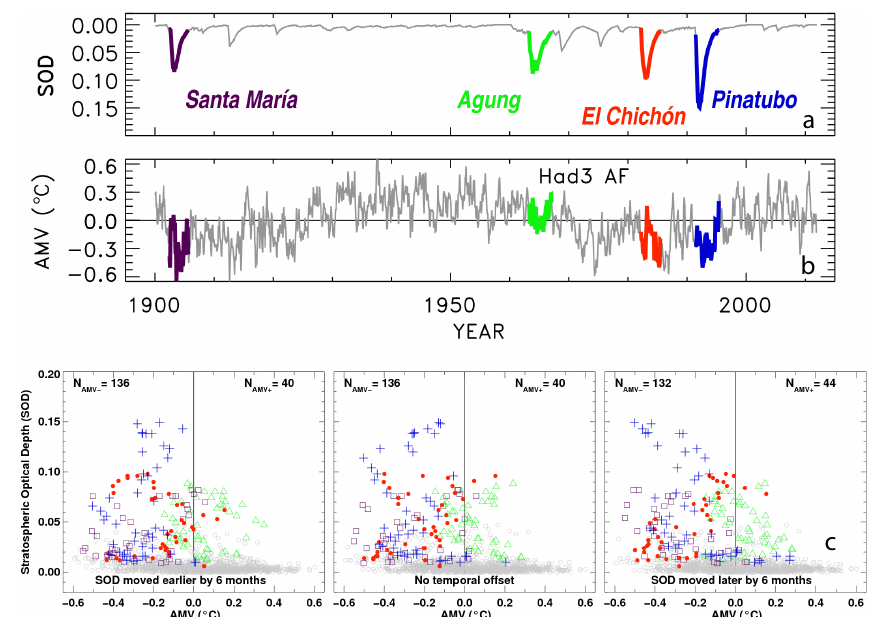
Fig. 10. (a) Monthly mean stratospheric optical depth (SOD) from Sato et al. (1993). The four major volcanoes, Santa Mar´ıa (purple), Mount Agung (green), El Chich´on (red) and Mt. Pinatubo (blue) are indicated. (b) Monthly mean Atlantic Multidecadal Variability index calculated by detrending HadSST3 using anthropogenic radiative forcing (AMV Had3 AF ) . Line is the same as shown in Fig. 5d, except AMV index during the times SOD exceeded 0.01, following the four major volcanic eruptions since 1900, are coloured as in (a) . (c) Scatter plots of SOD versus AMV index. In the centre, SOD is plotted versus AMV index with no time shift. Data collected during the four major volcanic eruptions since 1900 are coloured as in (a) . The numerical values on the top of the plot tabulate the number of months the AMV index was either positive or negative, when SOD exceeded 0.01 after these four major eruptions. The left hand panel shows a scatter plot for a shift of SOD six months earlier in time and the right-hand panel shows a scatter plot for a shift of SOD six months later in